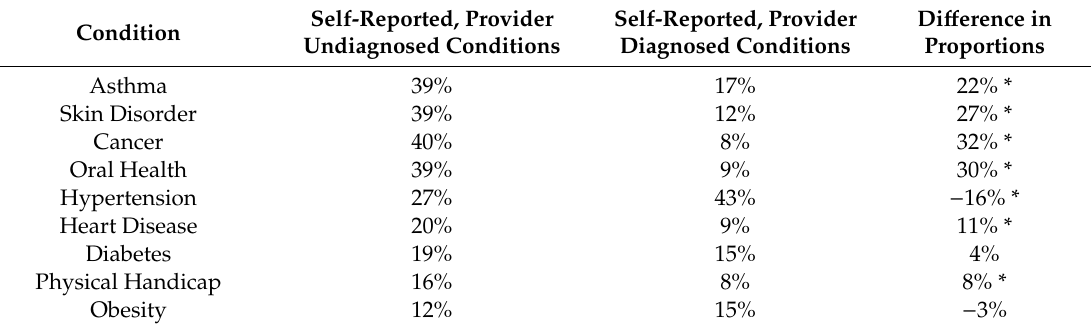
Table 8. Self-reported, provider undiagnosed and self-reported, provider-diagnosed conditions of the respondents are shown. Asterisks indicate statistically significant di ff erences at the α = 0.05